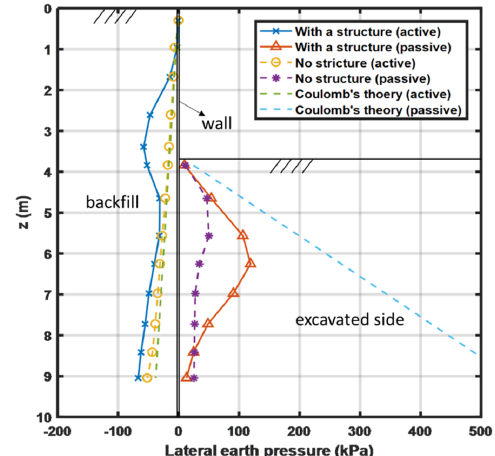
Figure 7. Horizontal earth pressures acting on the retaining wall.